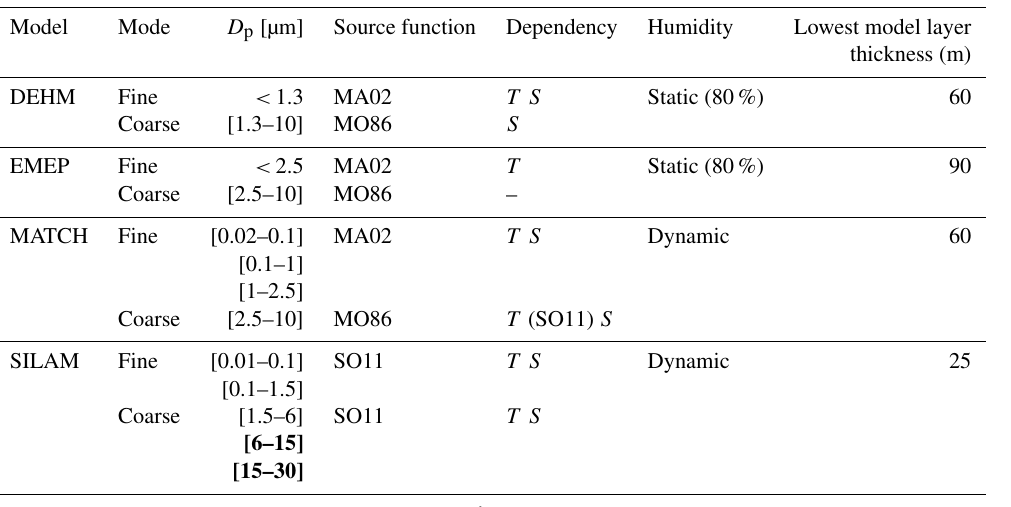
Table 1. Model characteristics for SSA